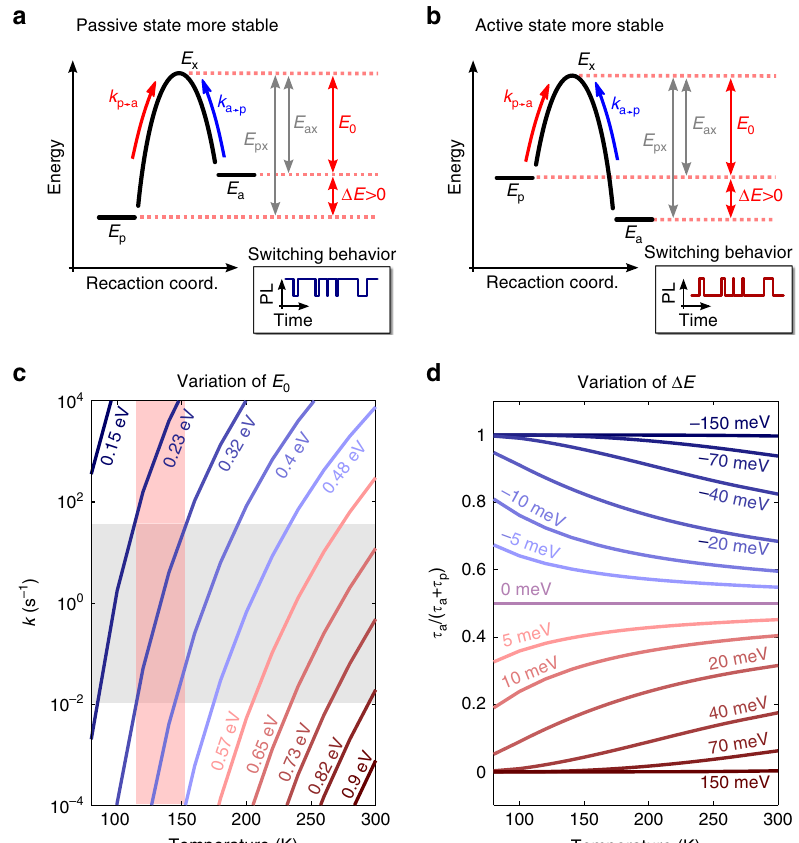
Fig. 5 Proposed model for switching of the quencher between the active and passive state. Panel a sketches the possible energetic arrangements between active and passive states. The states are characterized by their energies E a and E p , respectively and the energy level of the barrier E x . The passive state can be either energetically below (left panel) or above (right panel) the active state. In order to switch between the two metastable con fi gurations (active and passive), the quencher needs to overcome an energetic barrier E ax ¼ E x (cid:3) E a or E px ¼ E x (cid:3) E p depending on in which state (active or passive) the system stays initially. Depending on which of the two barriers is higher, the switching pattern is different, i.e. long passive times in case of an energetically favored passive state (left panel) and long active times when the active state is lower in energy (right panel), as shown in the schematic blinking transients in the insets. b Switching rate k as function of temperature for different activation barriers E 0 ¼ min ð E ax ; E px Þ . Here, we calculated k according to Equation 3 (note that E 0 ¼ E ax ¼ E px for Δ E = 0). The grey area indicates the range of switching rates that can be detected experimentally. The upper limit is given by the measurement time and the lower limit by the integration time. For example a quencher with E 0 = 0.32 eV gives blinking observed from 120 to 150 K, as highlighted in red. c Fraction of time the quencher spends in the active state for different temperatures and energetic spacings Δ E between active